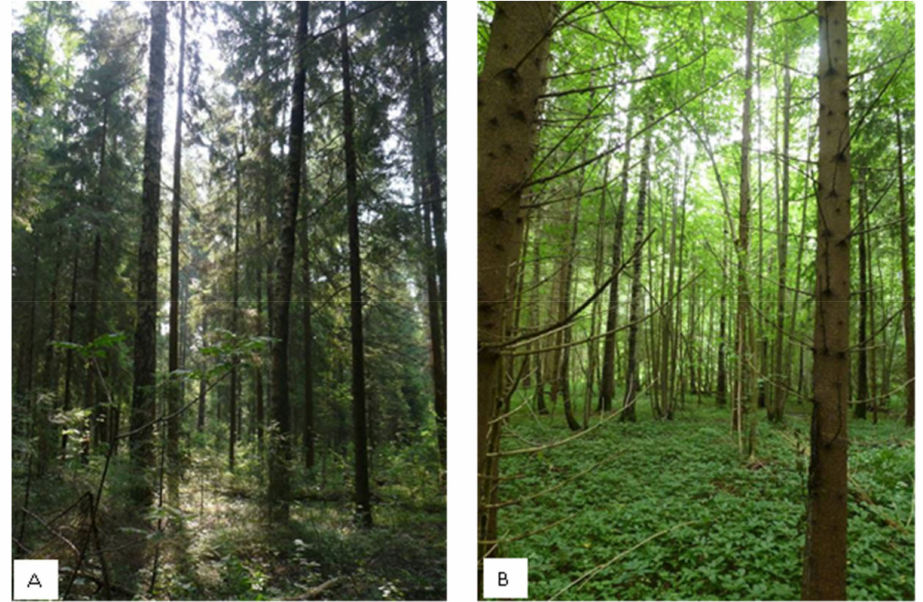
Figure 3. ( A )—Spruce–small-leaved forests; ( B )—Spruce broad herb forests (Photo by